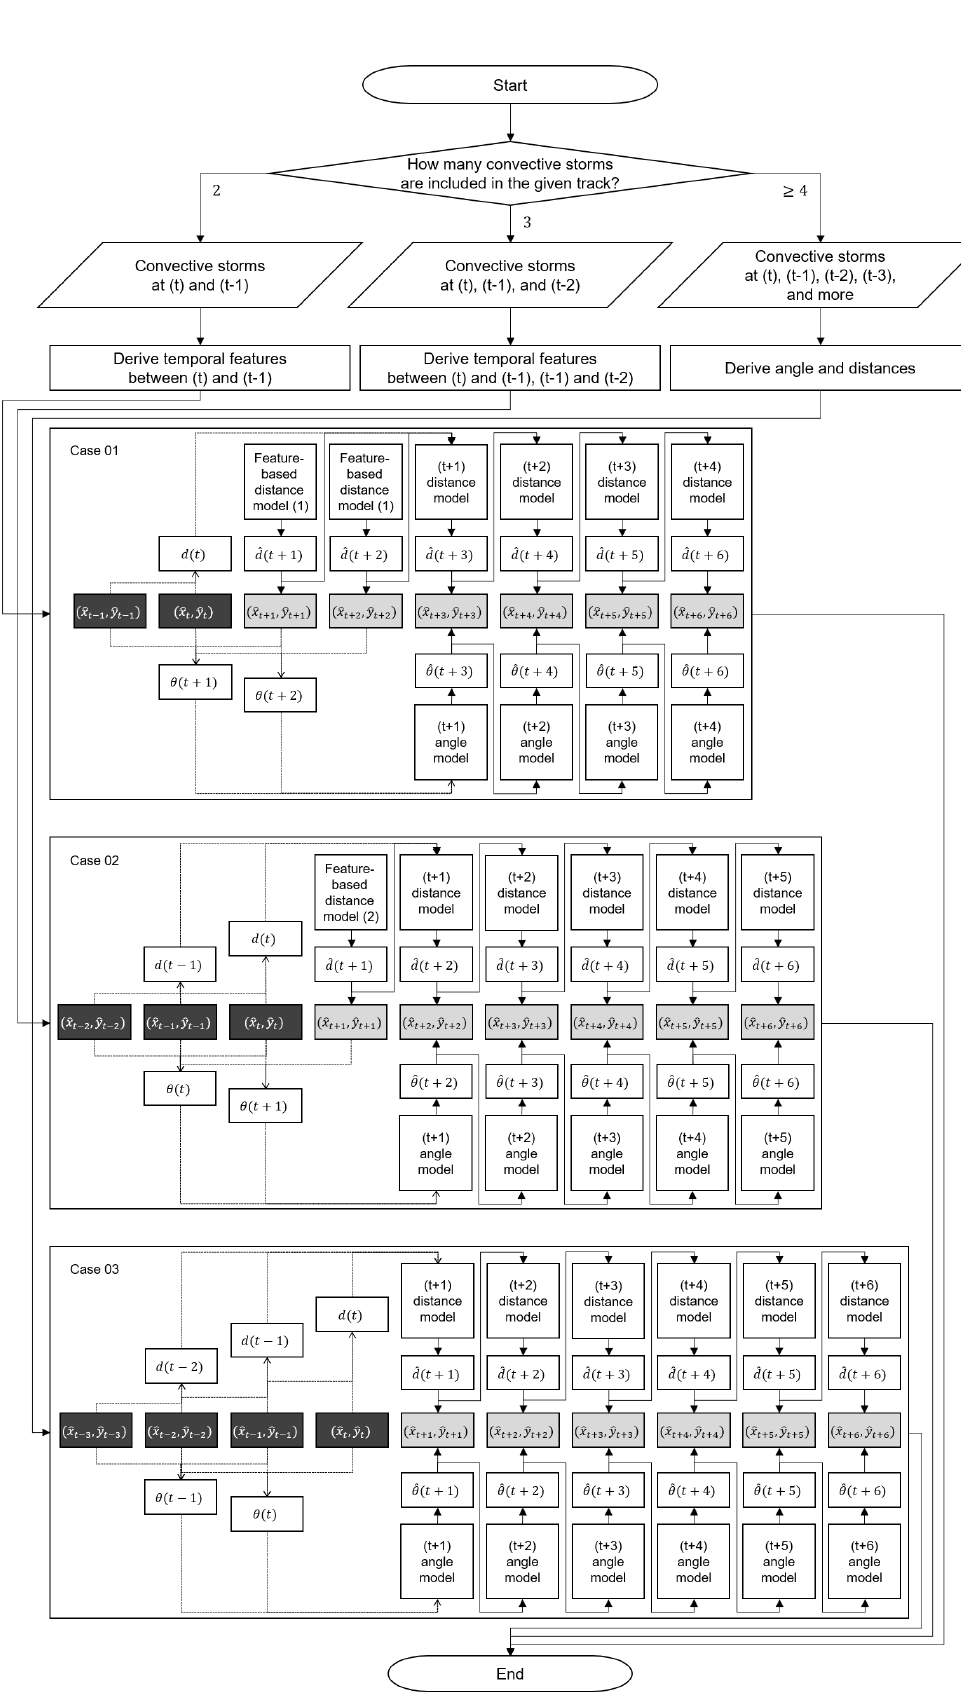
Figure 5. The proposed convective storm future location prediction